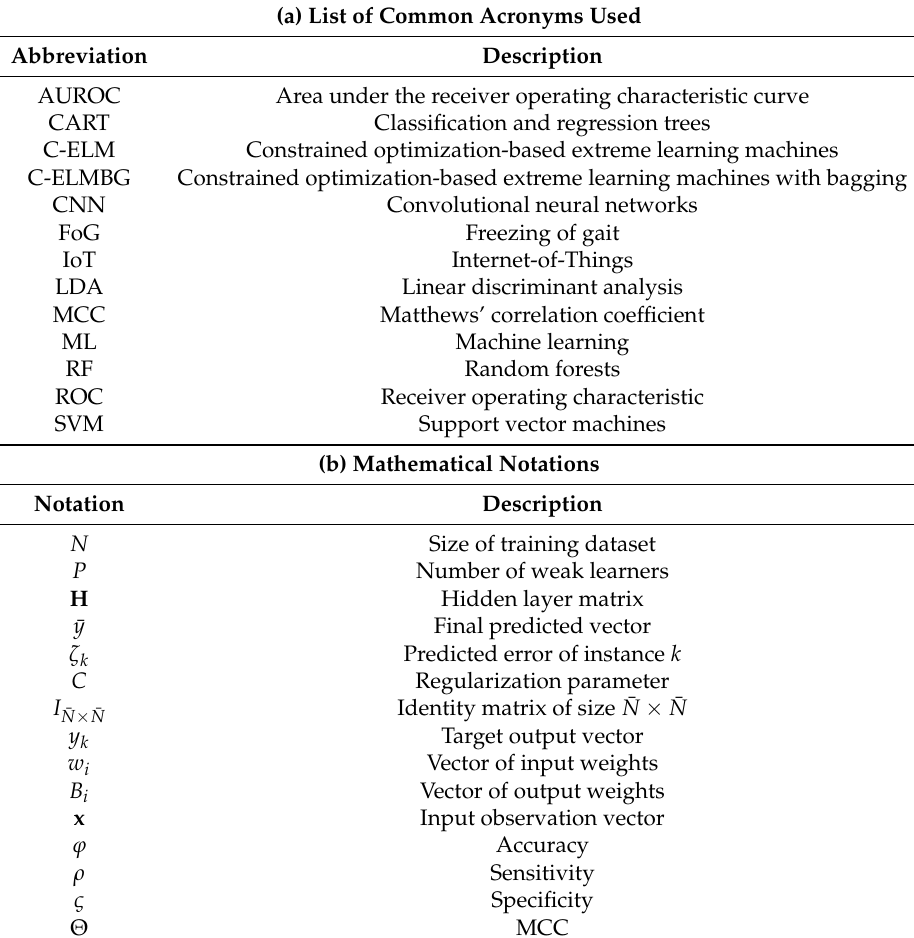
Table 1. Acronyms and